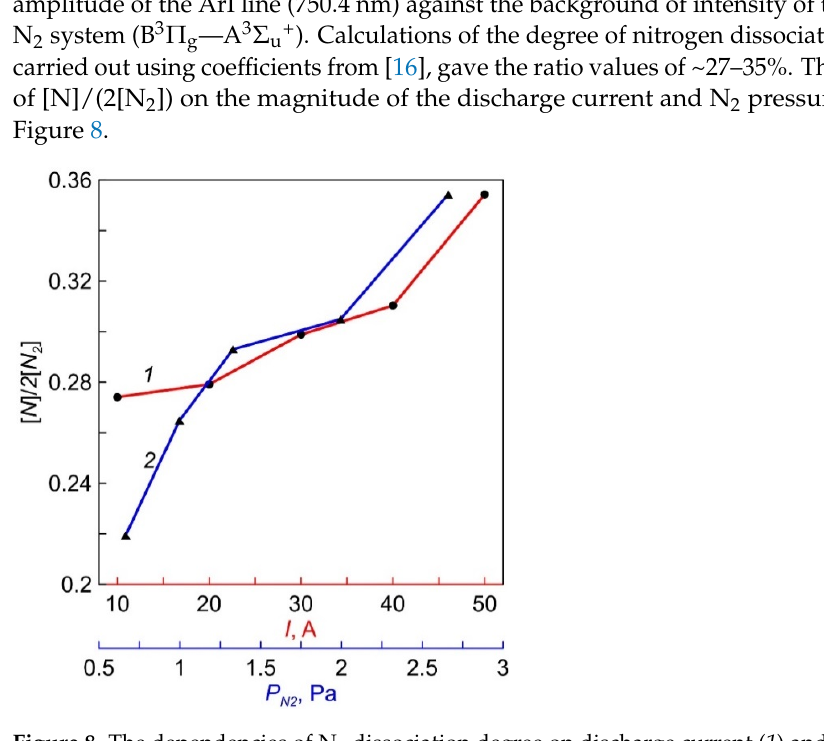
Figure 8. The dependencies of N 2 dissociation degree on discharge current (1) and N 2 pressure (2).